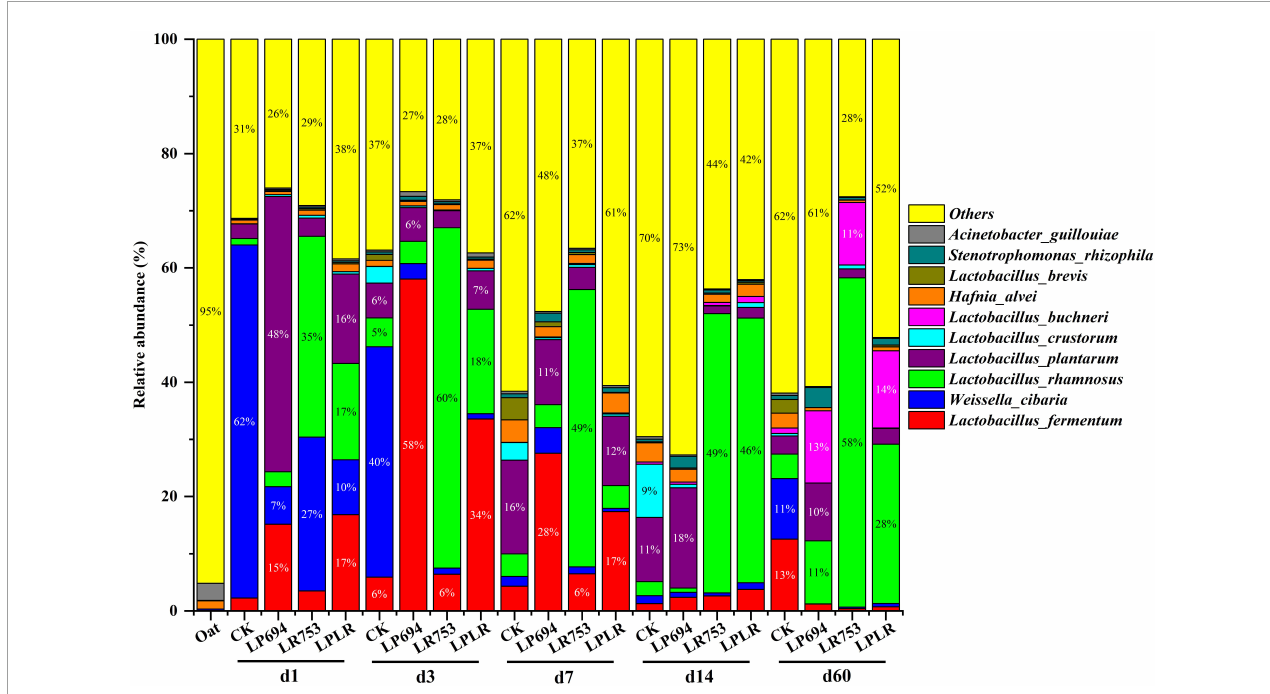
FIGURE3 Relative abundance of bacteria at the species level for oat silages at different days of ensiling with and without lactic acid bacterial inoculation. CK, sterilized water; LP694, Lactobacillus plantarum 694; LR753, Lactobacillus rhamnosus 753; LPLR, 50% LP694 + 50% LR753; d, ensiling days; OAT.F, fresh